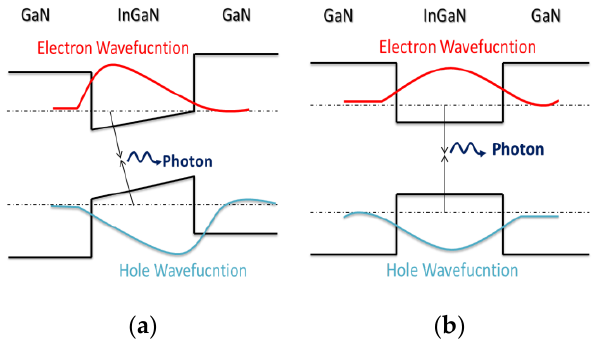
Figure 1. Visualization of quantum-confined stark effect (QCSE) in InGaN/GaN quantum well (QW). Structure ( a ) suffers from QCSE while ( b ) is free from it.